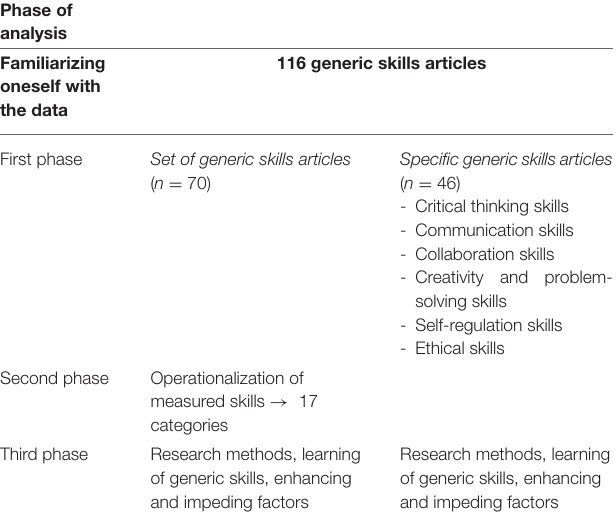
TABLE 1 | Phases of